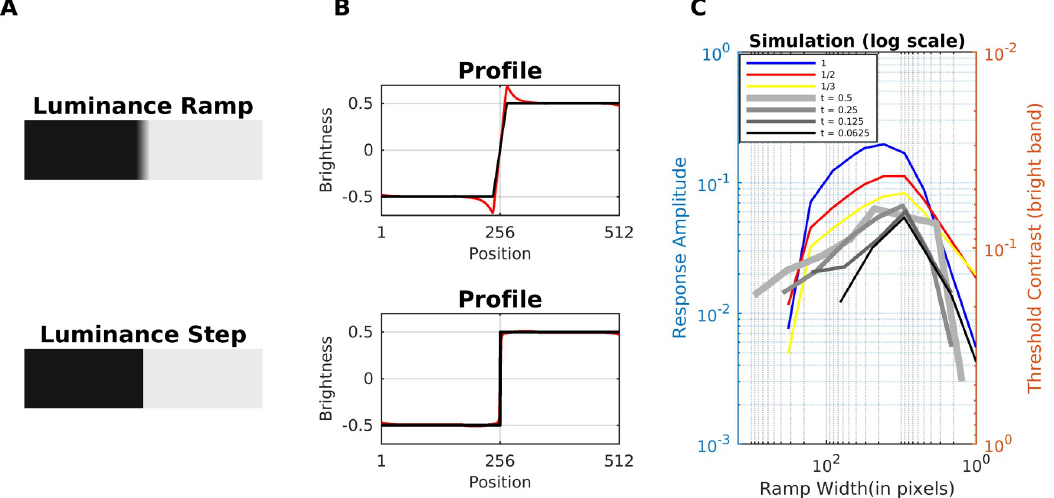
Fig 20. Model prediction for mach bands. (A) Top, A luminance ramp that leads to the perception of Mach bands close to the knee points of the ramp. Bottom, a luminance step (no Mach bands are perceived). (B) Profiles plots of estimated brightness (red line) compared with the corresponding input (black line) of A. (C) Brightness magnitude (at the inflection point of the ramp) as a function of ramp width. The plots show the predictions of our model on the perceived strength of the bright Mach band. The colored curves (left axis label: response amplitude) represent model predictions for different dynamic ranges (i.e., differences between luminance values of the upper and the lower plateau, see legend). The gray curves are the threshold contrasts (axis label on the right) for seeing the bright Mach bands at trapezoidal waveforms according to [104]. The trapezoidal waves are characterized by a shape parameter t (see legend; t = 0.5 corresponds to a triangular wave).